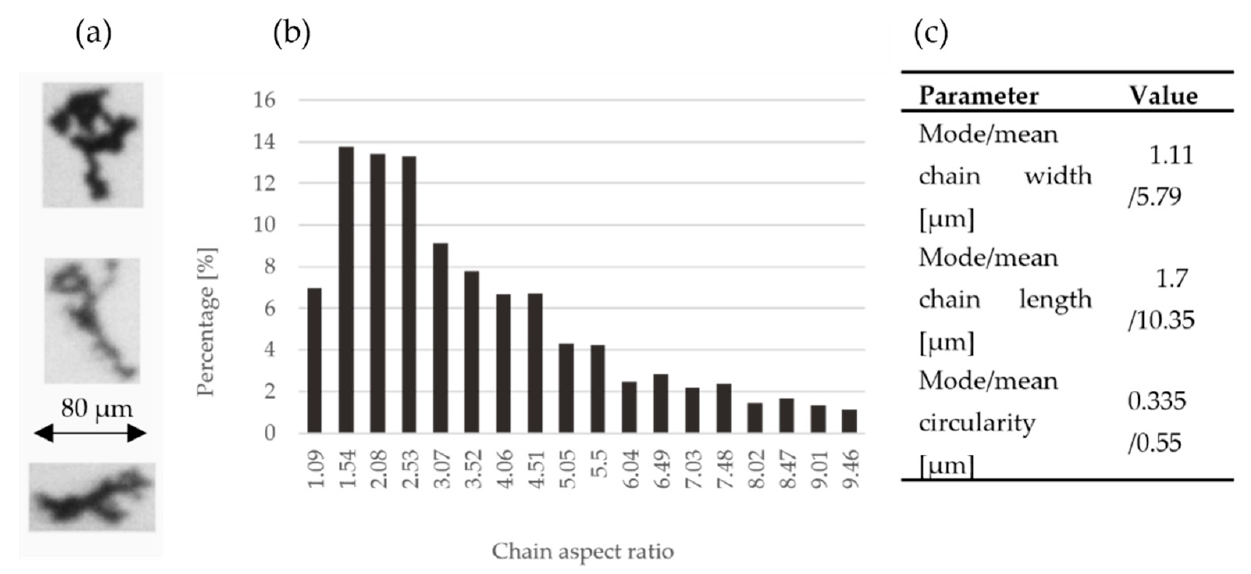
Figure 2. Binary dynamic image analysis for Ni powder: ( a ) images of Ni powder; ( b ) percentages of the individual values of chain aspect ratio graph; ( c ) characteristic parameters of powder.